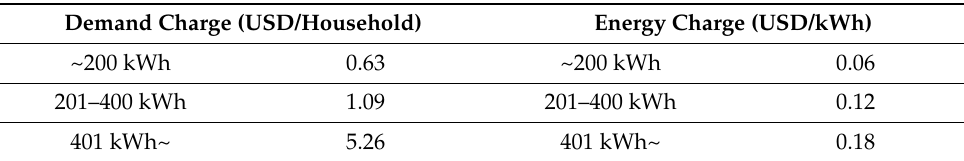
Table 5. Electricity tariff for residential service.